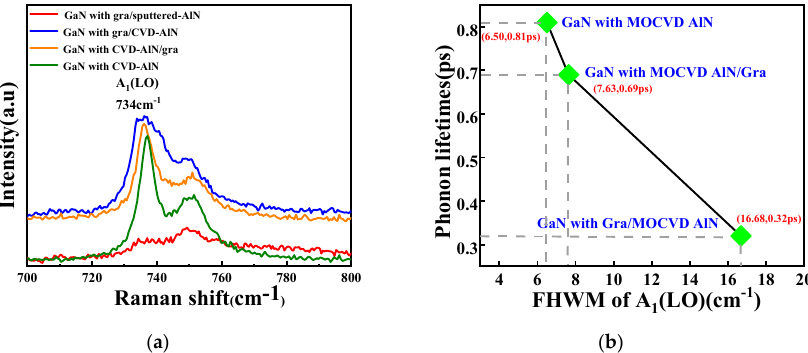
Figure 5. ( a ) A 1 (LO) peak of Raman spectra of GaN films grown on sapphire substrate with graphene/sputtered AlN buffer layer (sample 1), graphene/MOCVD AlN buffer layer (sample 2), MOCVD AlN/graphene buffer layer (sample 3), and MOCVD AlN buffer layer (sample 4) in the wave region of 700 – 800 cm − 1 . ( b ) The relationship between the FWHM of A 1 (LO) phonon and the phonon lifetimes in the four different samples.